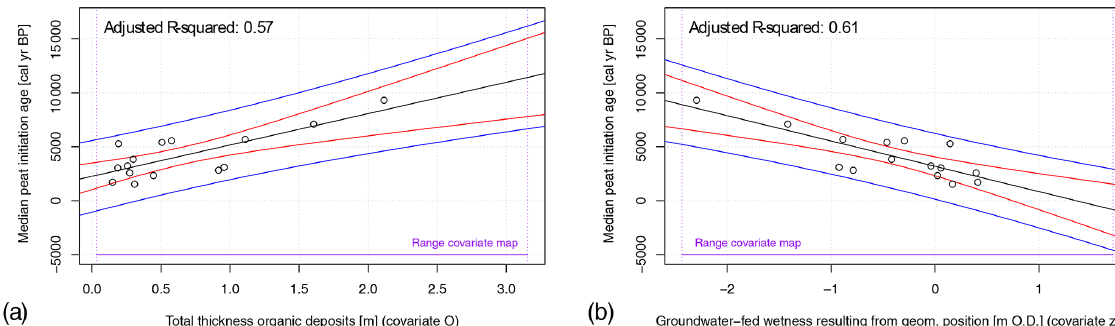
Figure 6. Linear regressions, showing the relationships between median peat initiation age and (a) the total thickness of organic deposits [ O ] and (b) groundwater-fed wetness that results from geomorphological position [ z P H ]. Both regressions were significant with p < 1 × 10 − 3 . Observations are indicated by the black circles. The regression line is shown in black; the 95% confidence interval of the regression line is indicated in red, and the 95% prediction interval is in blue. The range of the covariate maps is indicated in purple and also visible in Fig. 7b and d.